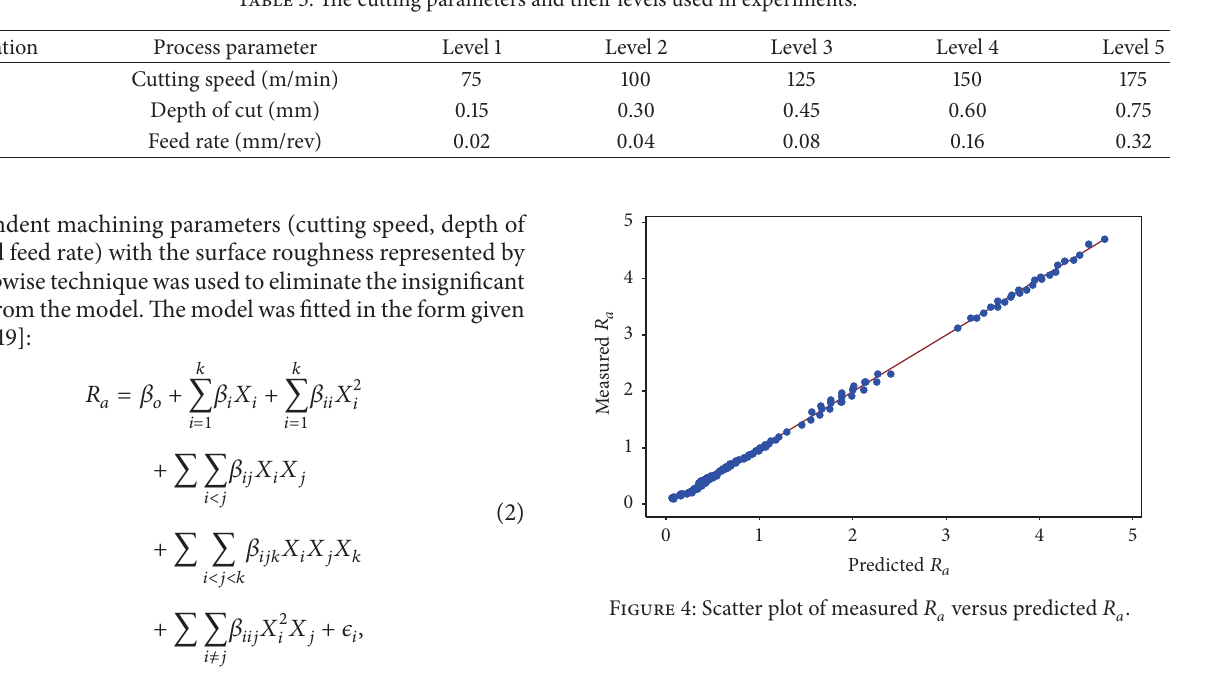
Table 3: The cutting parameters and their levels used in experiments.